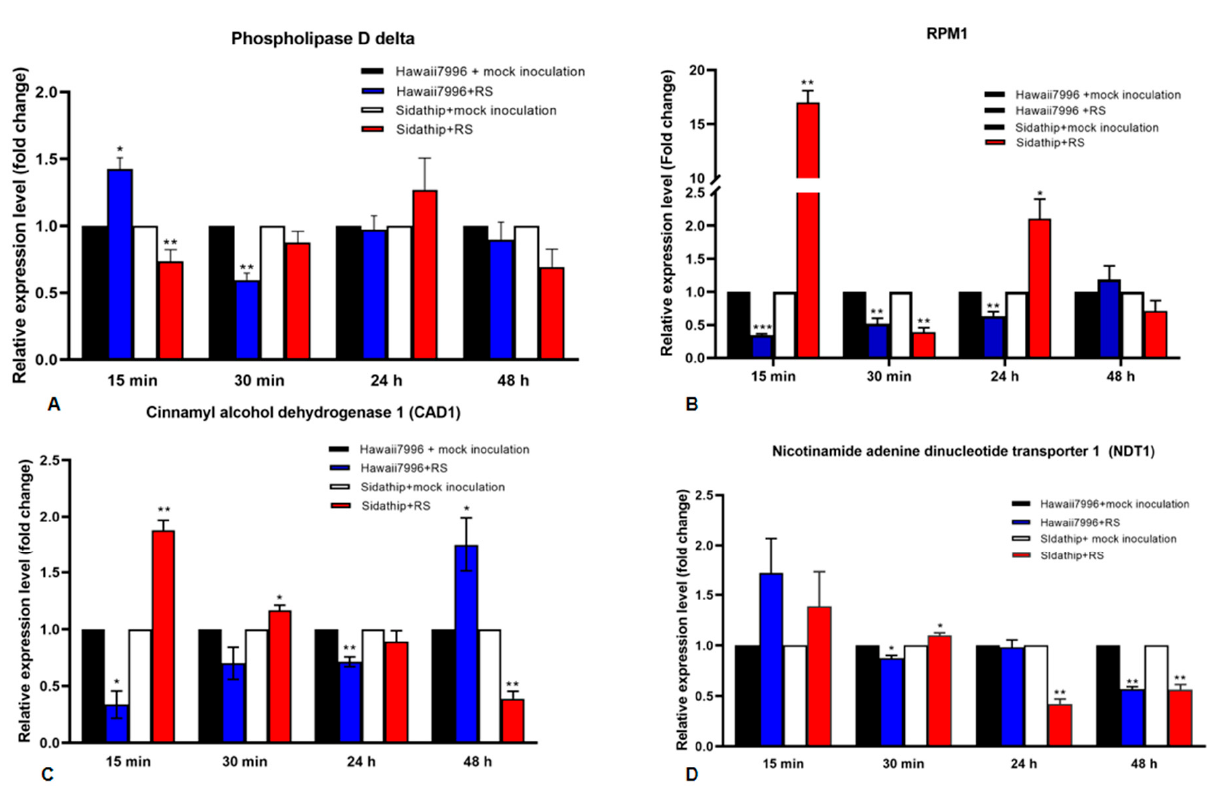
Figure 4. Time course of quantitative Real Time PCR analysis of four genes in susceptible and resistant tomato cultivars, Sidathip and Hawaii7996 inoculated with Ralstonia solanacearum . Total RNA was extracted from the stems of resistant tomato cv. Hawaii7996 and susceptible tomato Sidathip at 15 min, 30 min, 24 h, and 48 h after inoculation with Ralstonia solanacerum or distilled water for control. The control samples collected from Hawaii7996 and Sidathip treated with water were used for calibration. The level of expression of the genes shows ( A ) phopholipase D delta, ( B ) RPM1, ( C ) cinnamyl alcohol dehydrogenase 1 (CAD1), and ( D ) nicotinamide adenine dinucleotide transporter 1 (NDT1). Error bar represents the standard deviation obtained from three biological replicates. Asterisks indicate the statistical significance level by p -value obtained by two tailed student’s t -test: p -value < 0.05 (*), < 0.01 (**), and < 0.001 (***).